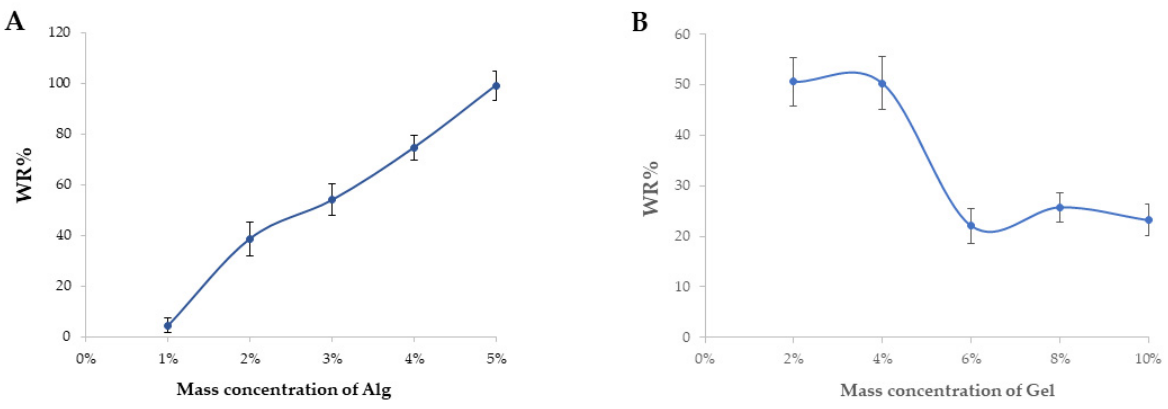
Figure 3. Water absorption of ( A ) sodium alginate and ( B ) gelatin with different mass concentra- tions.